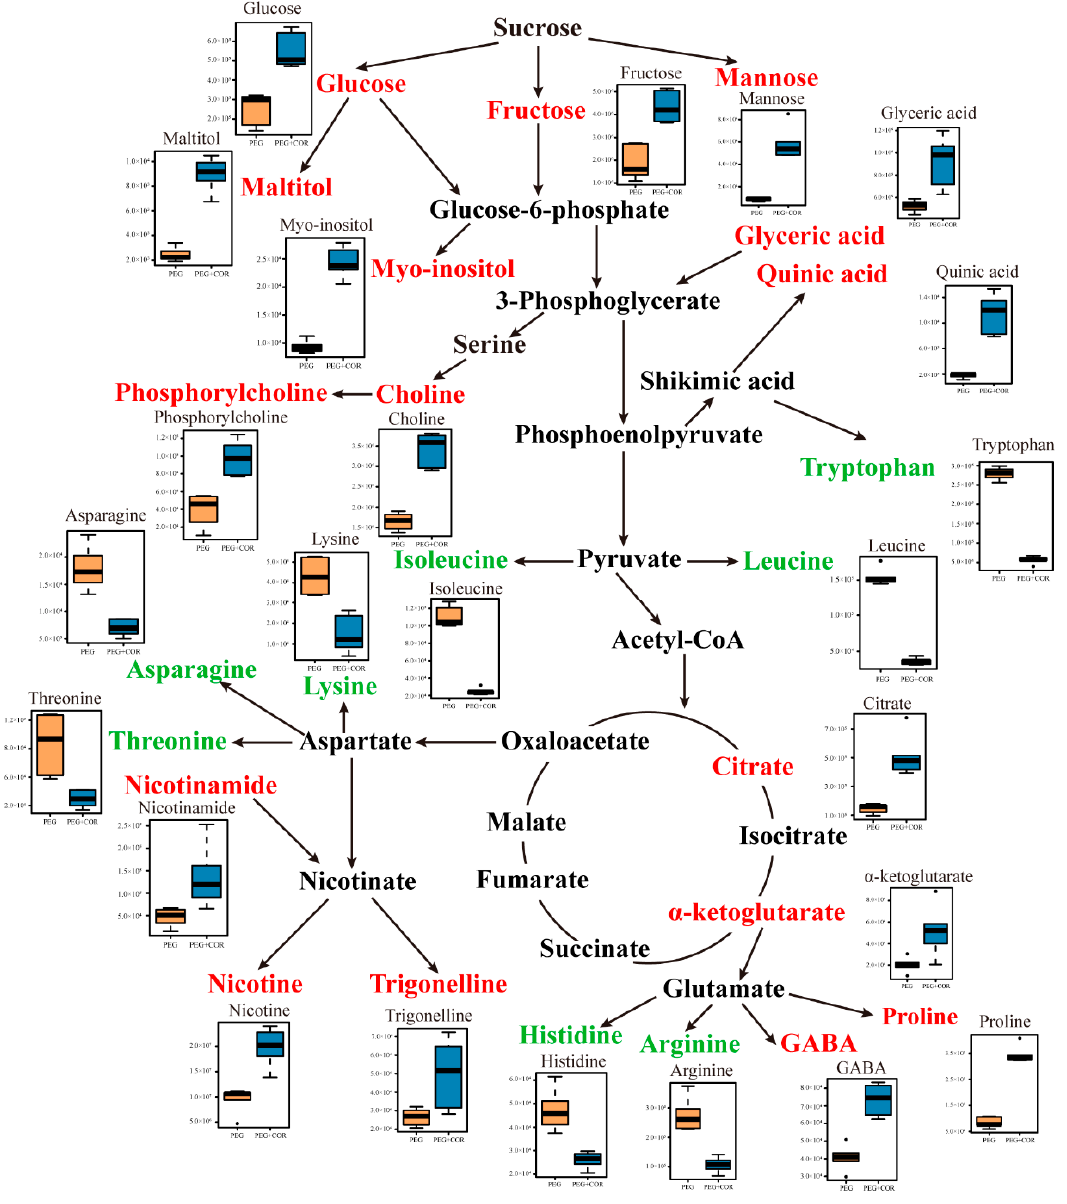
Figure 5. Summary scheme showing the main COR-induced metabolic changes under osmotic stress. The metabolites with red/green color indicate up-regulation/down-regulation in response to COR. The relative abundance of metabolites in different treatment under PEG was shown as box plots.